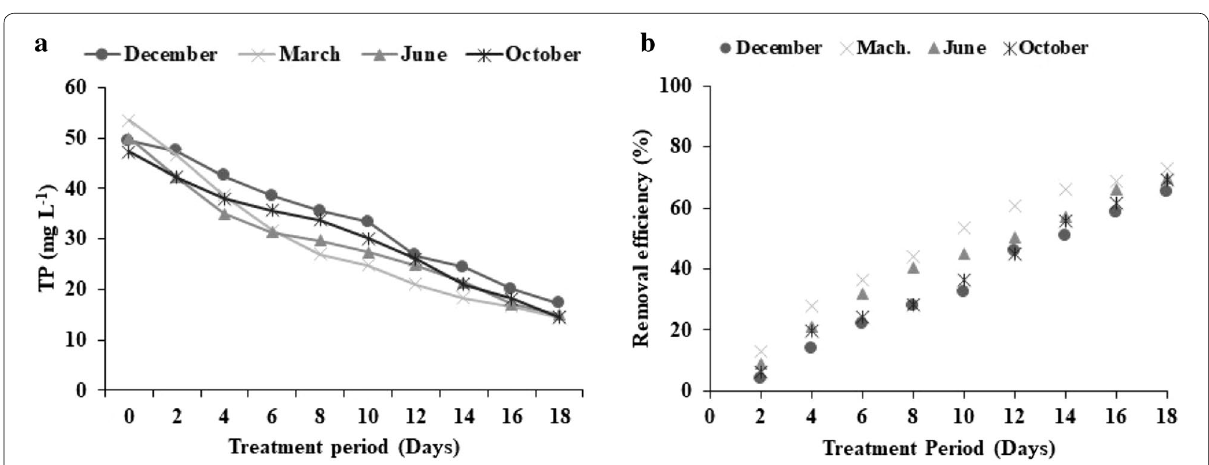
Fig. 5 Change of concentration ( a ) removal efficiencies ( b ) of TP over the experimental periods of each